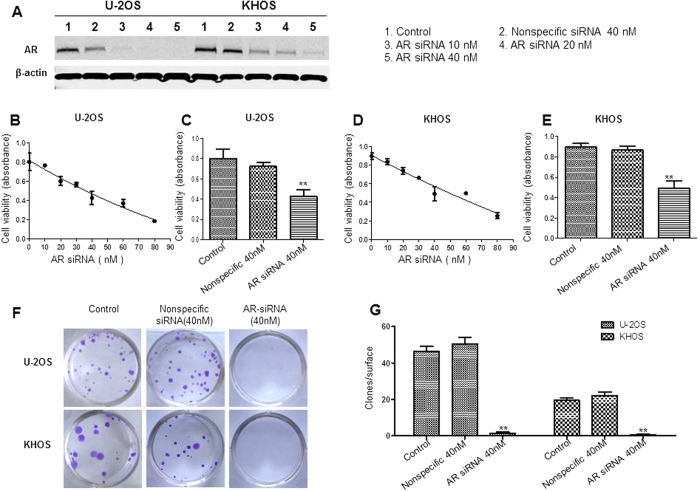
Effects of AR siRNA in osteosarcoma cell lines.(A) Expressions of AR in osteosarcoma cell lines with AR siRNA. (B,C) AR siRNA inhibits viability in osteosarcoma cell line U-2OS. The relative sensitivity of each line with AR siRNA was determined by MTT. (D,E) AR siRNA decreases cell viability in osteosarcoma cell line KHOS. (F,G) AR siRNA inhibits colony formation units in osteosarcoma cell line U-2OS and KHOS. *P < 0.05, **P < 0.01 (compared with control cells).